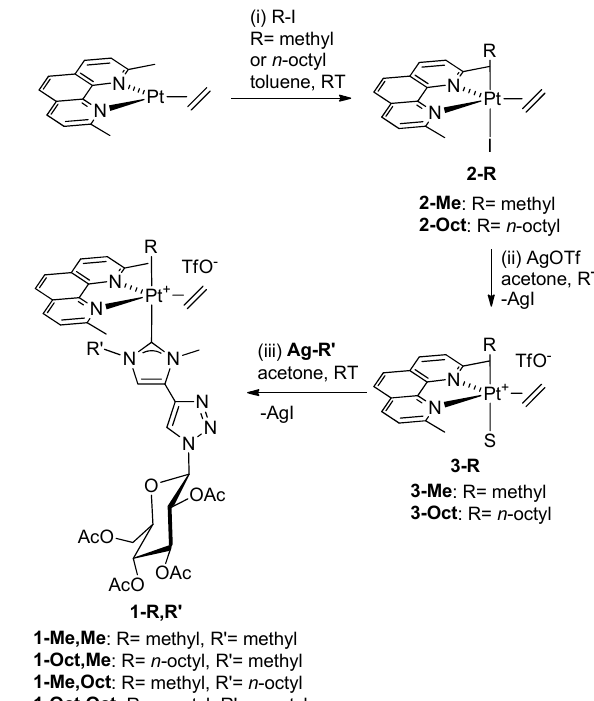
Figure 3. The 1 H NMR spectra of Im (trace 1) and Im-Oct (trace 2) in CDCl 3 . The platinum precursors used to synthesise the glucoconjugated complexes were obtained through the oxidative addition (path i of Scheme 2) of methyl iodide or n -octyl iodide to the Pt(0) precursor [Pt(dmphen)(ethene)], affording the five-coordinate species 2-Me and 2-Oct in excellent yields as light yellow powders. Treatment with silver triflate in acetone promoted the formation of the solvato species 3-Me and 3-Oct . They were immediately reacted with the appropriate silver carbene complex Ag-R’ (iii), obtained by treating the imidazolinium salts Im-R’ with silver oxide (iv). Transfer of the carbene ligand, assisted by the precipitation of Ag-I, completed the synthesis of the type 1-R,R’ complexes.